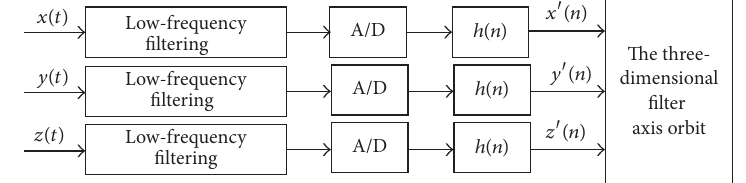
Figure 5: Diagram of the three-dimensional filtering